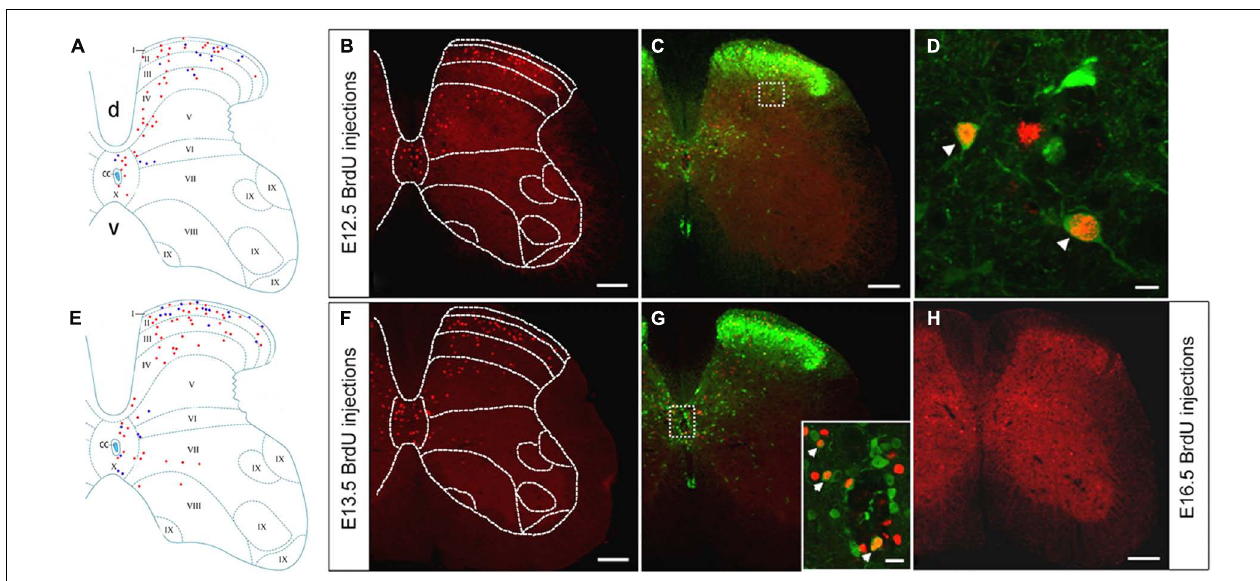
FIGURE 2 | Double-labeling of GFP (green) and BrdU (red) in the spinal cord of the GAD 67 -GFP knock-in mice following injection of BrdU at E12.5 and E13.5. (A,E) Schematic drawings showing the distribution of BrdU-positive cells and double-labeled neurons in the lumbar spinal cord following injection of BrdU at E12.5 (A) and E13.5 (E) . (A) The schematic drawing represents a single section and it corresponds to the same section illustrated in (B) . (E) The schematic drawing represents a single section and it corresponds to the same section illustrated in (F) . Red circles correspond to BrdU-positive cells and blue circles correspond to double-labeled neurons. (B,C) Distribution of the BrdU-labeled cells and double-labeled neurons in the